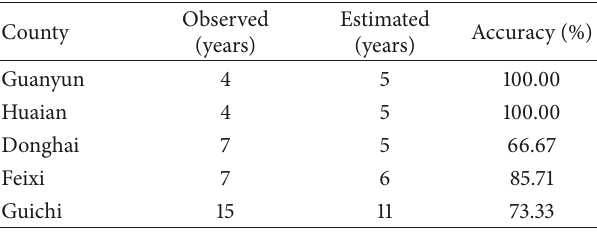
Table 3: Number of years with waterlogging events in historical records and estimated by the WPI for the five counties in the study area, respectively.